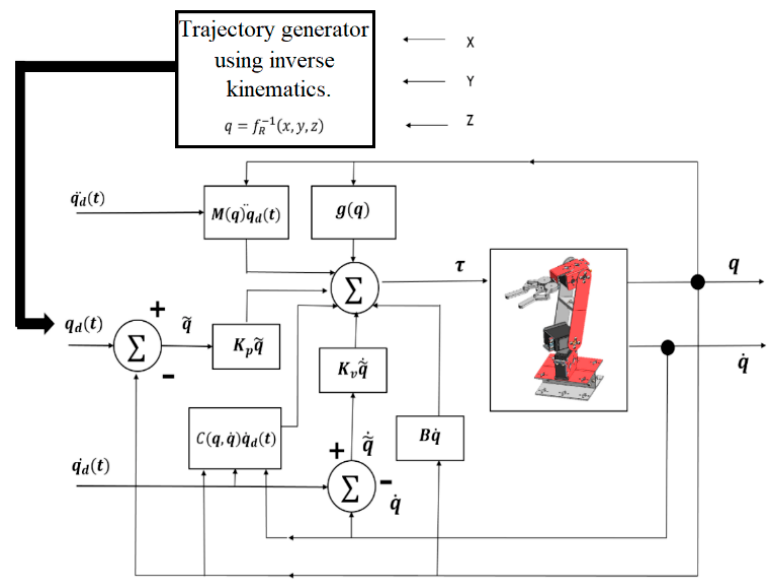
Figure 16. Block diagram of PD + control with gravity compensation.